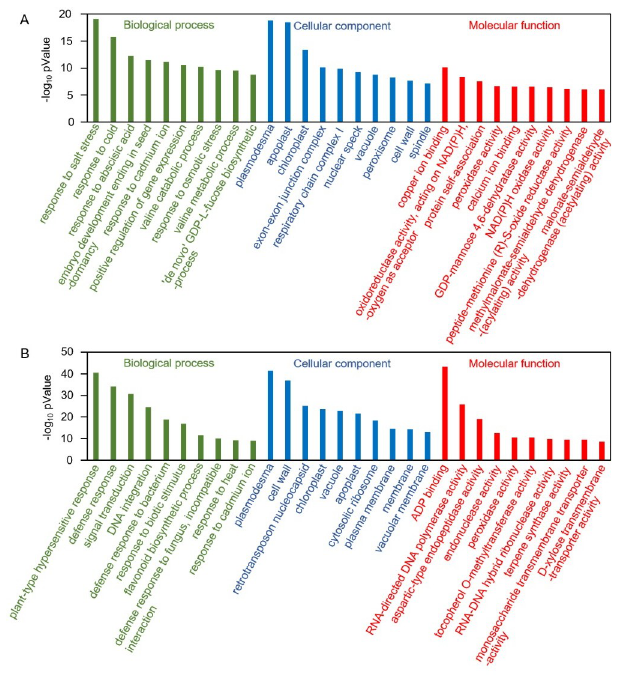
Fig 4. TOP10 GO terms for enrichment analysis of DEGs annotated to plant databases in each of the three GO categories. A: up-regulated DEGs; B: down-regulated DEGs.